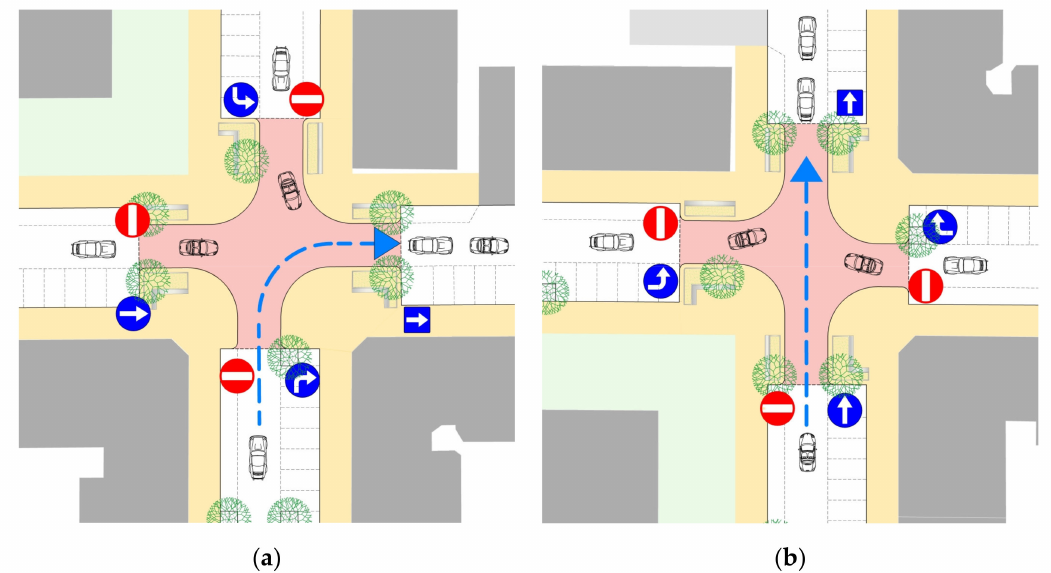
Figure 11. Traffic conditions and existing traffic management on the raised intersection at the end of: ( a ) testing ground No. 1; ( b ) testing ground No. 2. Source: own work of the author based on